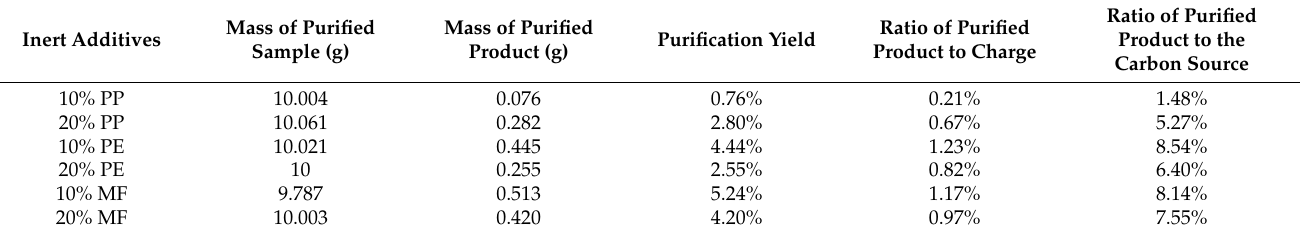
Table 4. Purification results from detonation soot.